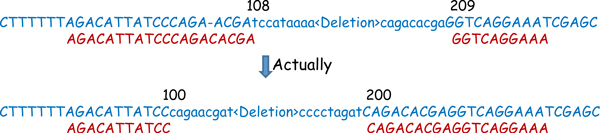
Adjustment of breakpoints. Length of a deletion can be adjusted. In the upper case, the left segment is mapped by Smith-Waterman algorithm with a gap and the length of the deletion is 101. In the lower case, the gap is removed and the length of the deletion is adjusted to 100.